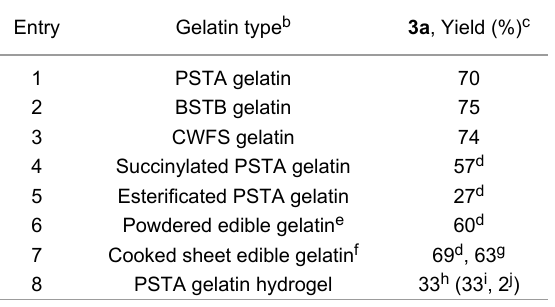
Table 2: Influence of different types of gelatin in the model Henry reac- tion between 1a and 2a in DMSO. a Entry Gelatin type b 3a , Yield (%)